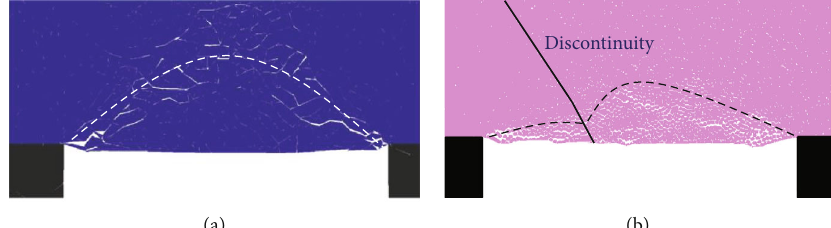
Figure 17: Roof fracture and instability characteristics of roadway with or without discontinuity: (a) fracture characteristic without discontinuity; (b) fracture characteristic with